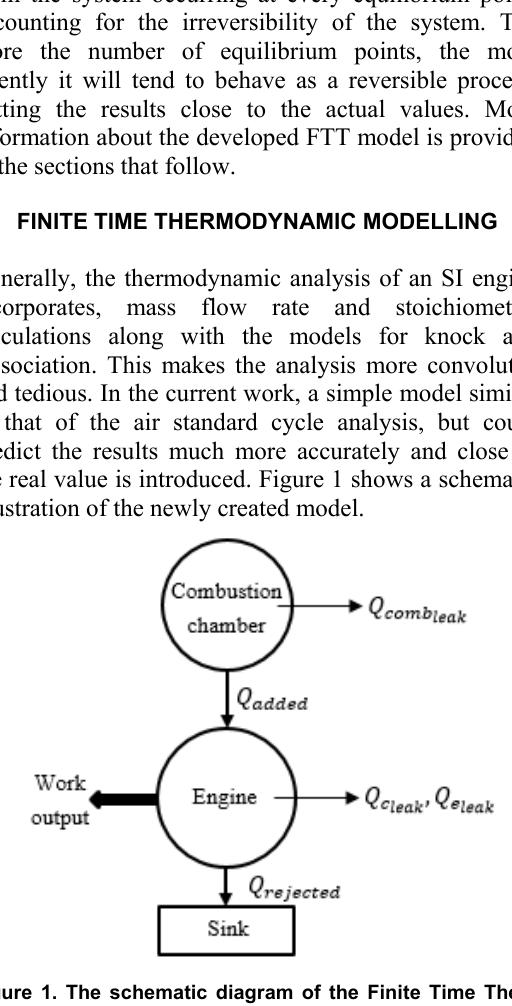
Figure 1. The schematic diagram of the Finite Time Ther– modynamic Model developed and associated energy